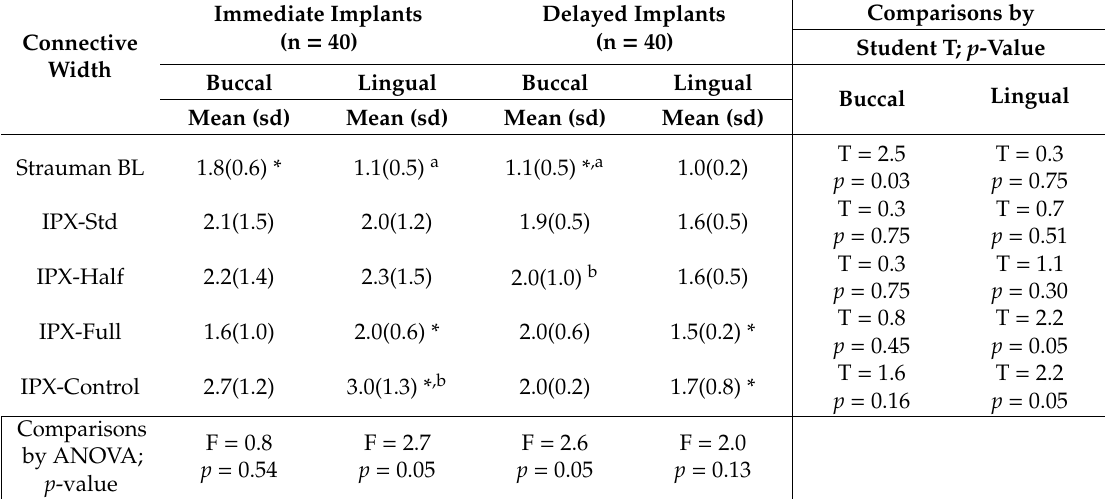
Table 4. Comparison of the connective width (the distance between aJE and B) between delayed and immediate implants in both the buccal and lingual sides (mm) among the implant subgroups. * Statistically significant inter-group comparisons according to ANOVA test ( p < 0.05). The letters (a,b) next to the symbol * indicate the groups that are statistically di ff erent after post hoc Bonferroni correction.